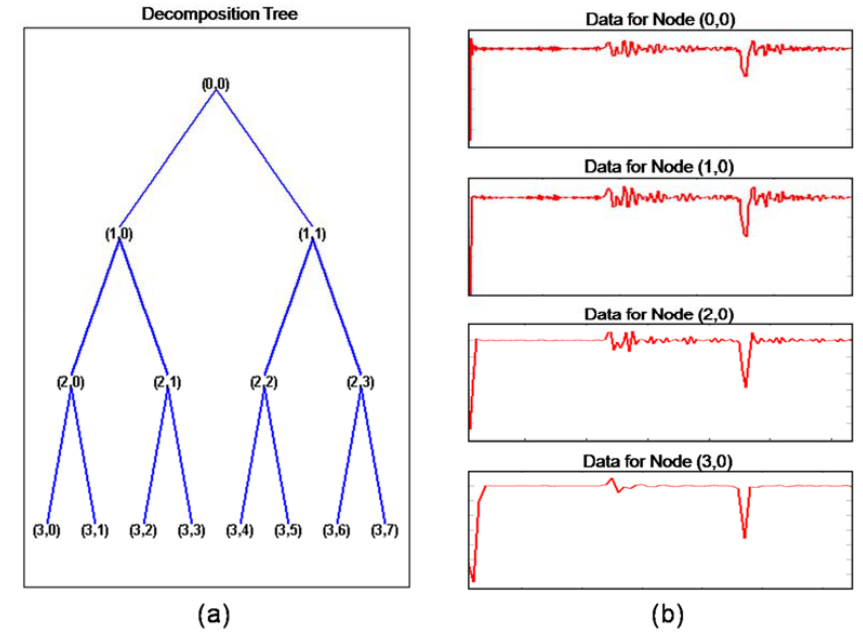
Figure 10. Signal decomposition: ( a ) Wavelet packet transform (WPT) decomposition tree; ( b ) Low-frequency components of the original signal of the simulated impact echo test of case